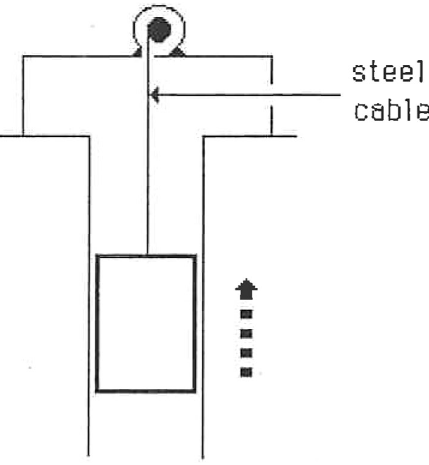
FIG. 5. Trace lines for question 17. From this plot it can be seen that option B is the correct response, with option A being a strong distractor. The item parameters used to make this plot were taken from Table III in